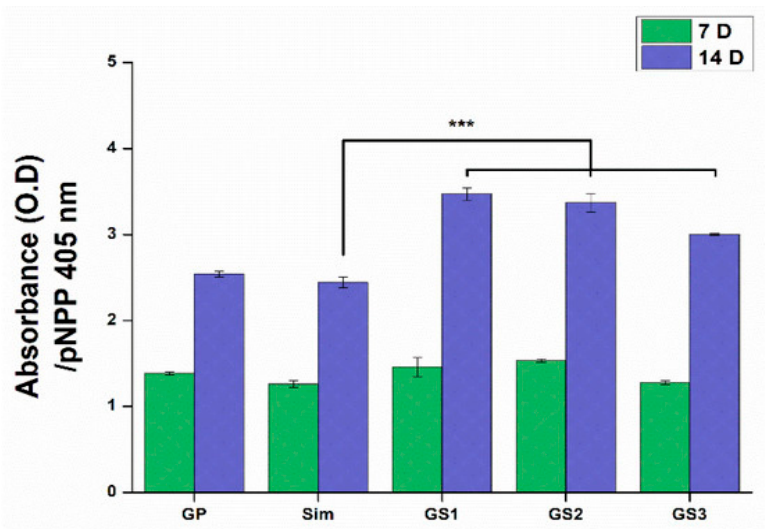
Figure 8. The ALP assay was performed in cells cultivated for 7 and 14 days. No significant differences were observed after 7 days, although remarkable differences were shown after 14 days when GS1 and GS2 exhibited enhanced ALP activity, while GS3 containing 1 µ M of Simvastatin presented a lower level of ALP. Error bars represent +/ − standard deviations ( n ≥ 3). *** p < 0.001